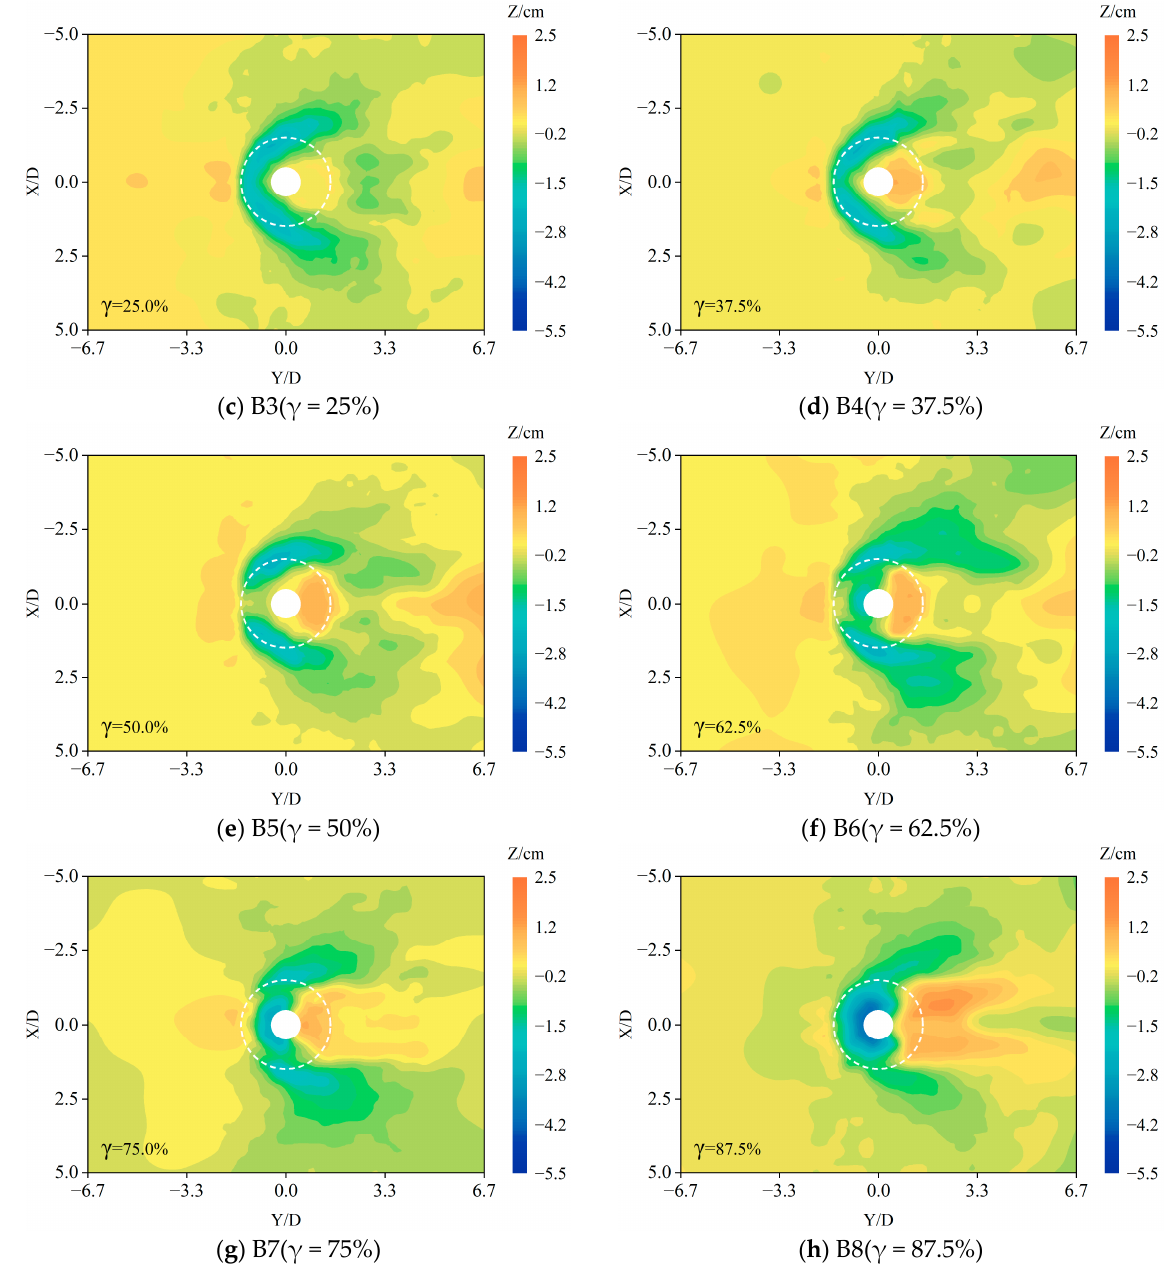
Figure 10. Local scour around the pier using a permeable collar with different porosities.